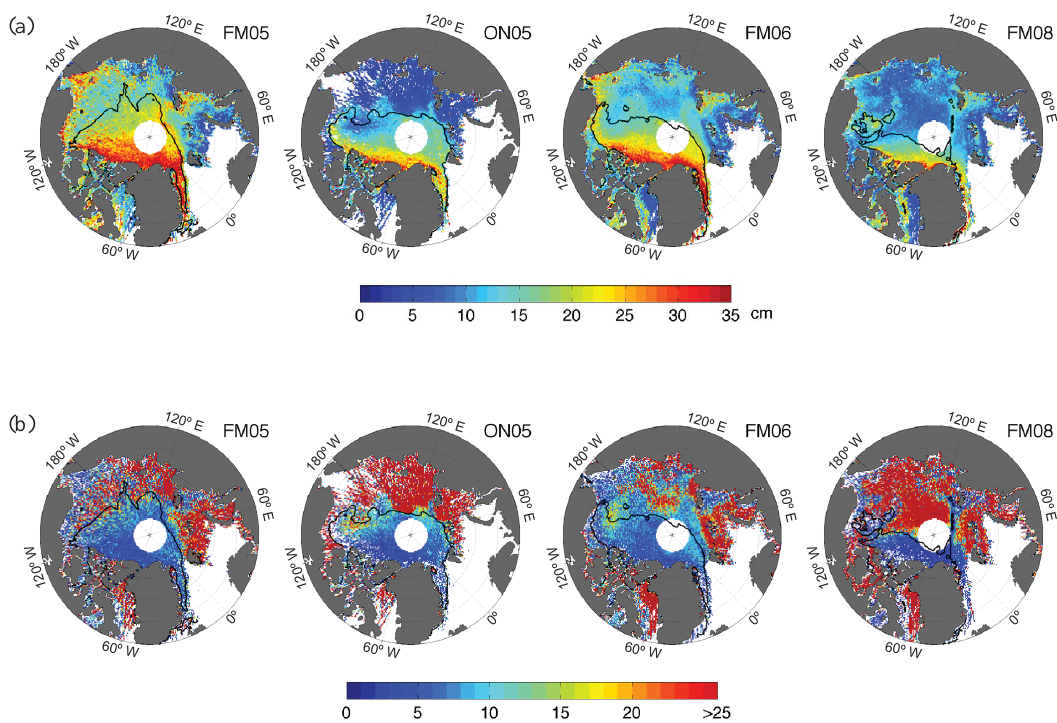
Figure 6. Standard deviation of detrended elevations h r (cm) (a) and number of tie points within 25km non-overlapping segments detected by the TP method (b) for FM05, ON05, FM06 and FM08 periods.